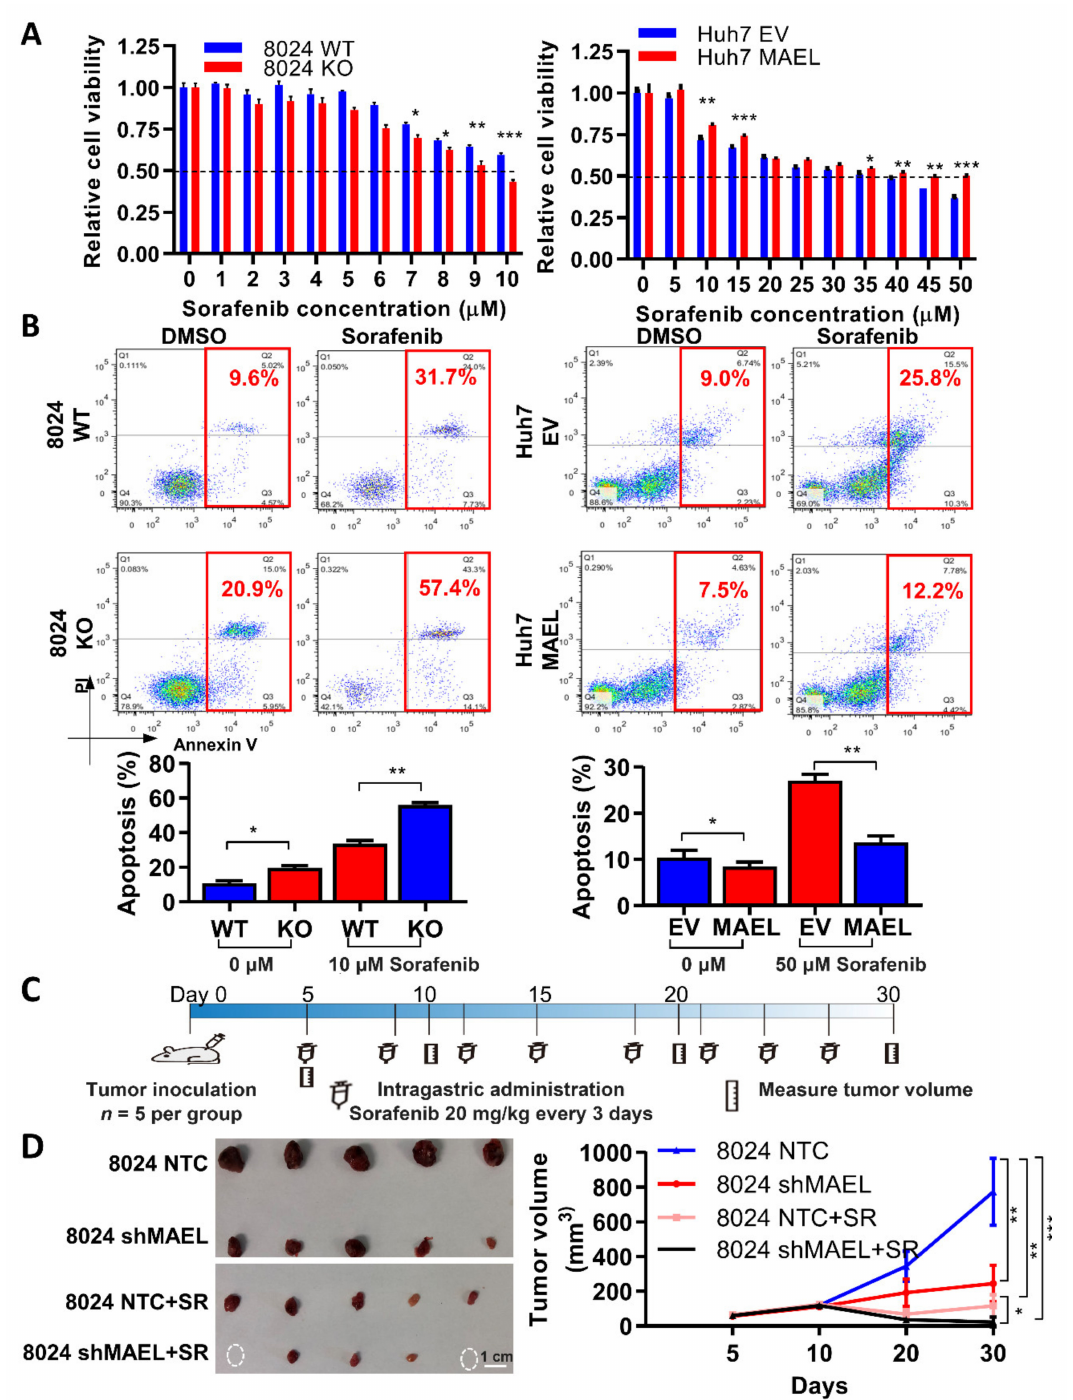
Figure 4. MAEL regulates HCC cell sensitivity to sorafenib. ( A ) XTT assay indicates cell viability upon sorafenib treatment in cells with MAEL overexpression or knockout. WT, nontarget control; KO, MEAL gene knockout; EV, empty vector control. ( B ) Representative Annexin V/PI staining dot plots and quantification of apoptosis in cells with or without sorafenib treatment. ( C ) Schematic illustration of sorafenib treatment in mice implanted with PLC8024 scramble and MAEL shRNA cells. ( D ) Representative images and tumor volume formed in mice subcutaneously injected with MAEL modulation cells with or without sorafenib treatment ( n = 5 per group). The circles stand for no tumor formatted. Scale bar stands for 1 cm. Data represent the mean ± SD of three independent experiments. * p < 0.05; ** p < 0.01; *** p <